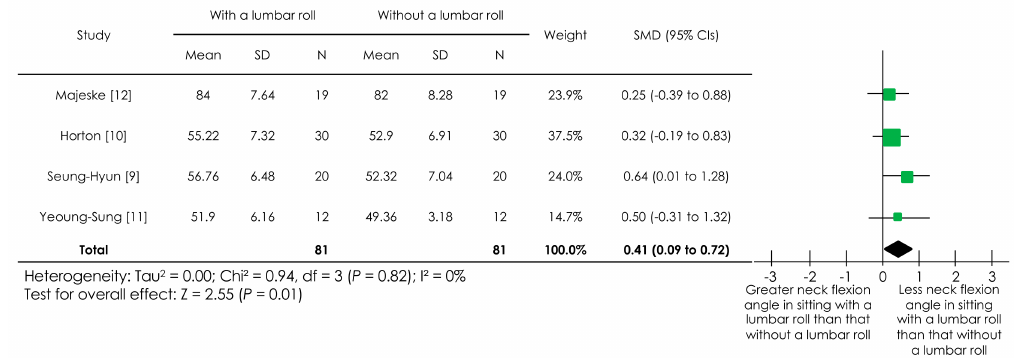
Figure 3. Post-hoc forest plot of the effect of a lumbar roll in sitting on a neck angle, excluding individuals with a cranio-vertebral angle < 51 ◦ . Abbreviations: SMD, standardized mean difference; CIs, confidence intervals.